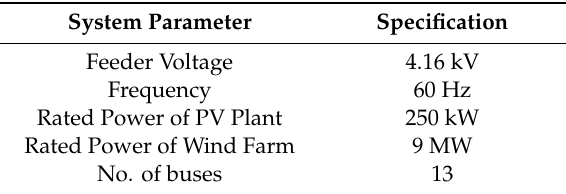
Table 4. Parameter values of modified IEEE 13 bus test system.